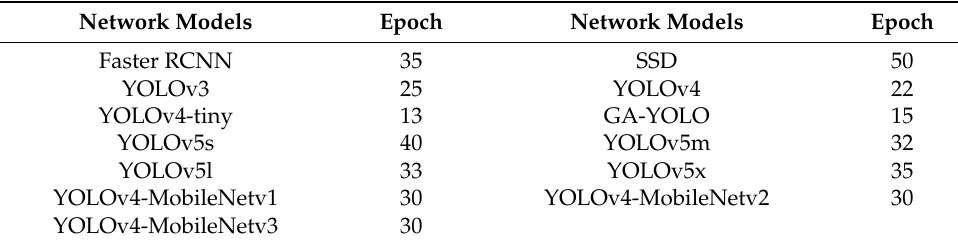
Figure 11. Loss convergence graphs of different network models. ( a ) Loss convergence graph of Faster RCNN; ( b ) Loss convergence graph of SSD; ( c ) Loss convergence graphs of YOLOv3, YOLOv4, YOLOv4-tiny and GA-YOLO; ( d ) Loss convergence graphs of YOLOv4-MobileNetv1, YOLOv4-MobileNetv2 and YOLOv4-MobileNetv3; ( e ) Loss convergence graphs of YOLOv5s; ( f ) Loss convergence graphs of YOLOv5m, YOLOv5l and YOLOv5x. Table 7. Convergence epochs of different network models.